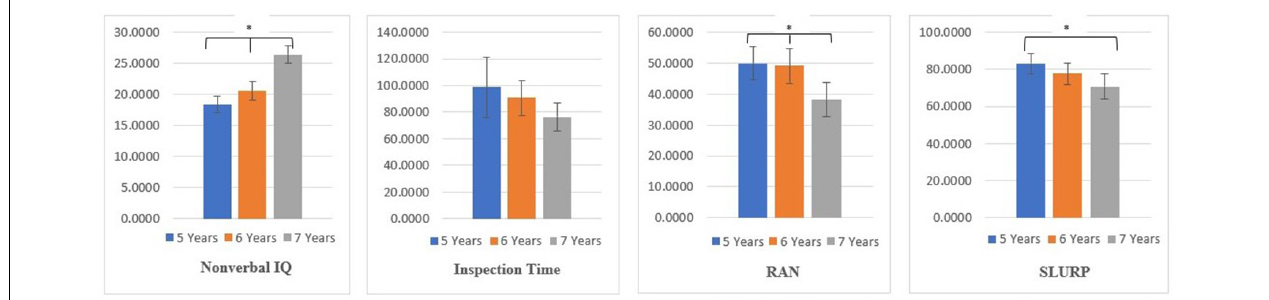
FIGURE 4 | Age group differences (+/- 95% Confidence Intervals) for, nonverbal IQ, rate of visual information processing (Inspection Time), visual-verbal processing (RNA), and visuomotor processing (SLURP). Note. ∗ p <